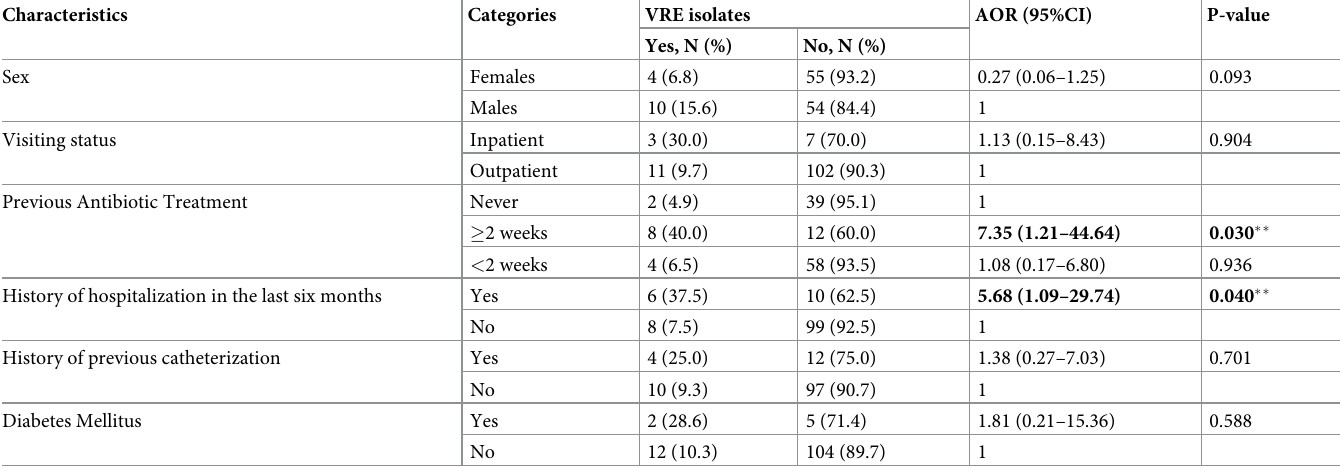
Table 5. Multivariable logistic regression analysis on factors affecting vancomycin resistant Enterococci among clients attending ART clinic at Arba Minch General Hospital, Southern Ethiopia October 2020.